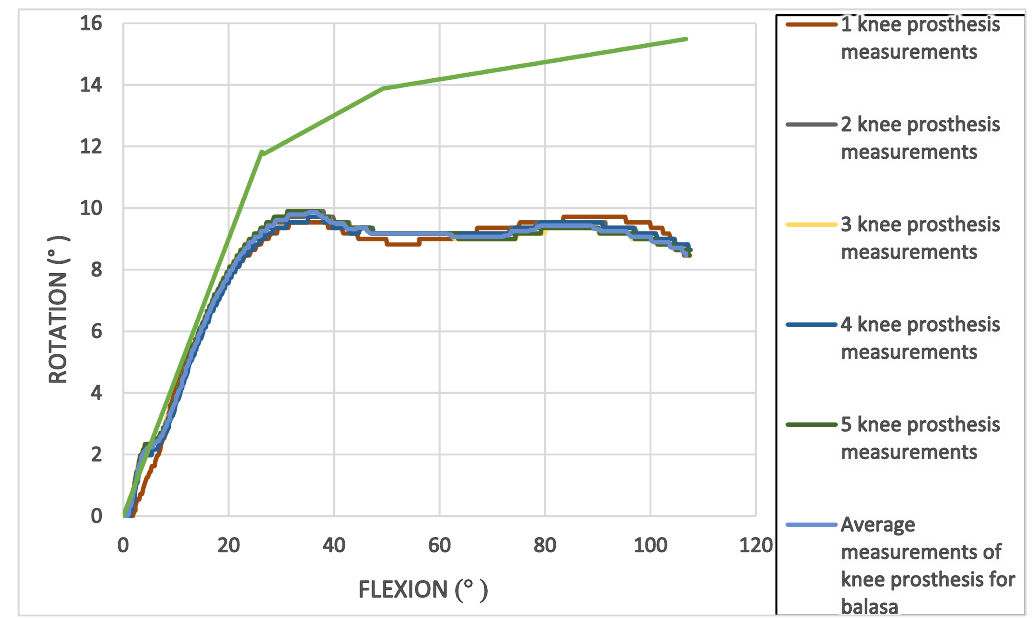
Figure 16. A graph of rotation against flexion for the knee prosthesis designed by Balassa and tested with their machine as compared with the regular movement of the human knee [12].